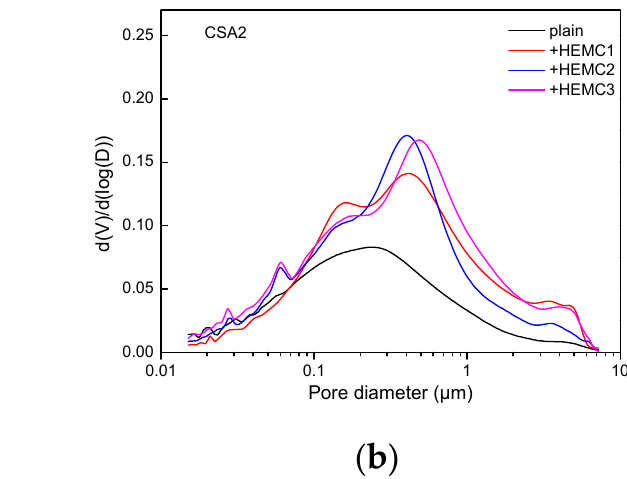
Figure 7. The pore size distribution of CSA cement mortars with and without HEMCs at 28 days: ( a ) CSA1, ( b ) CSA2. Porosity is always regarded as the primary element that affects the strength of cement mortar [44,45]. The porosity of CSA cement mortars with and without HEMCs at 28 days is illustrated in Figure 8. It can be seen that the porosity of plain CSA1 cement mortar was lower than that of plain CSA2 cement mortar, which is probably the reason why the strength of CSA1 cement mortar was higher. The addition of HEMCs led to a significant increase in the porosity of CSA cement mortar, which resulted in the decline of compressive strength. The MS/DS had no significant impact on the porosity of CSA cement mortar.